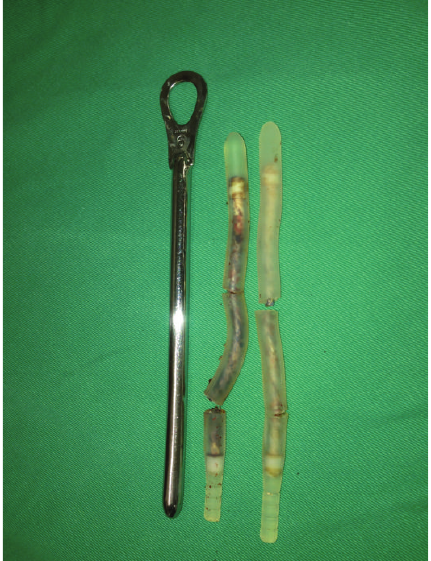
Figure 2: Surgical specimen after review procedure. Total fracture of the medial portion of the right and left rods. The left rod was fractured in three